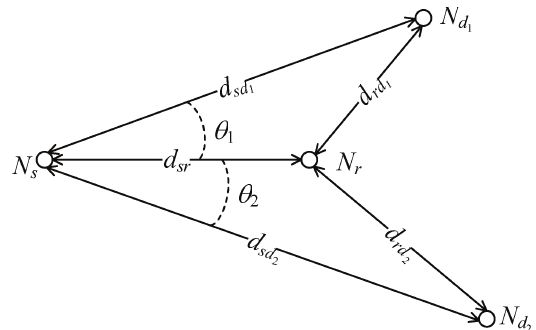
Figure 3. Geometry model of a relay broadcast channel